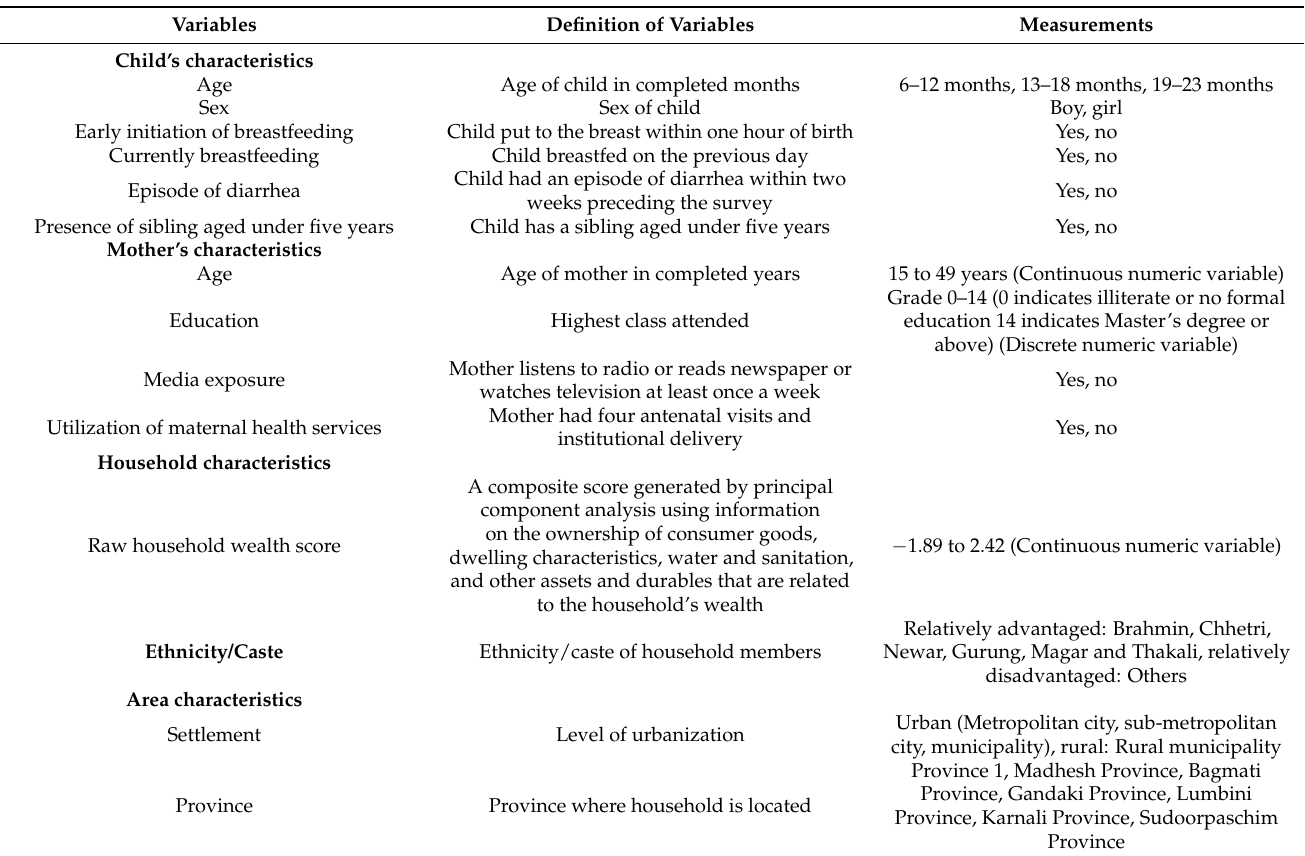
Table 1. Description of explanatory variables.